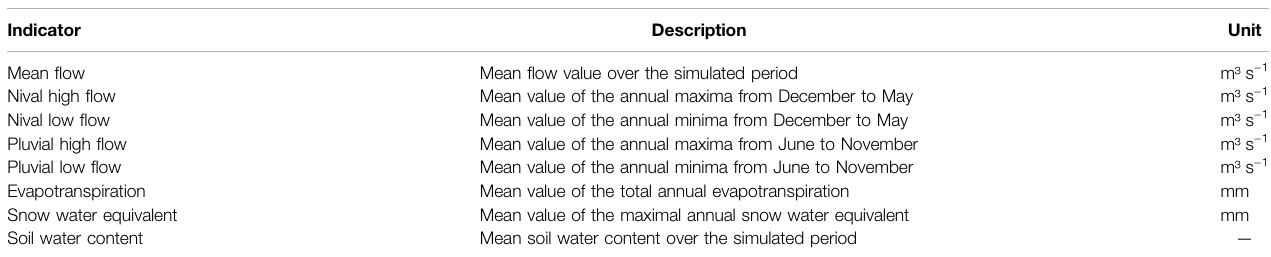
TABLE 6 | Description of hydrologic